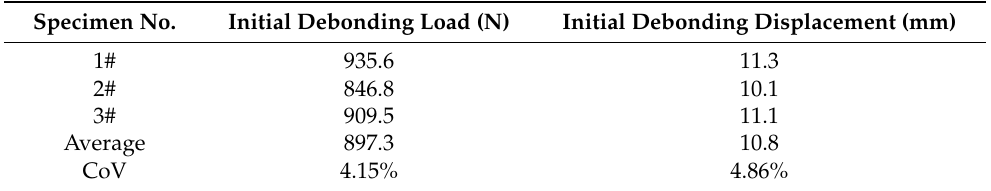
Table 4. The initial debonding load and displacement of the tested specimens.